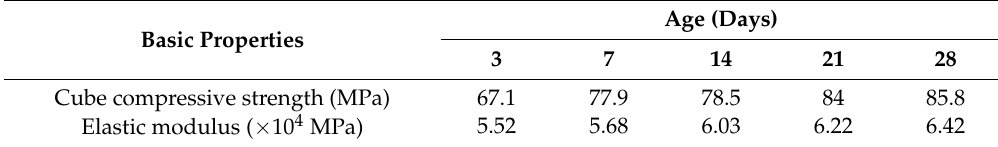
Table 5. Cube compressive strength and elastic modulus of